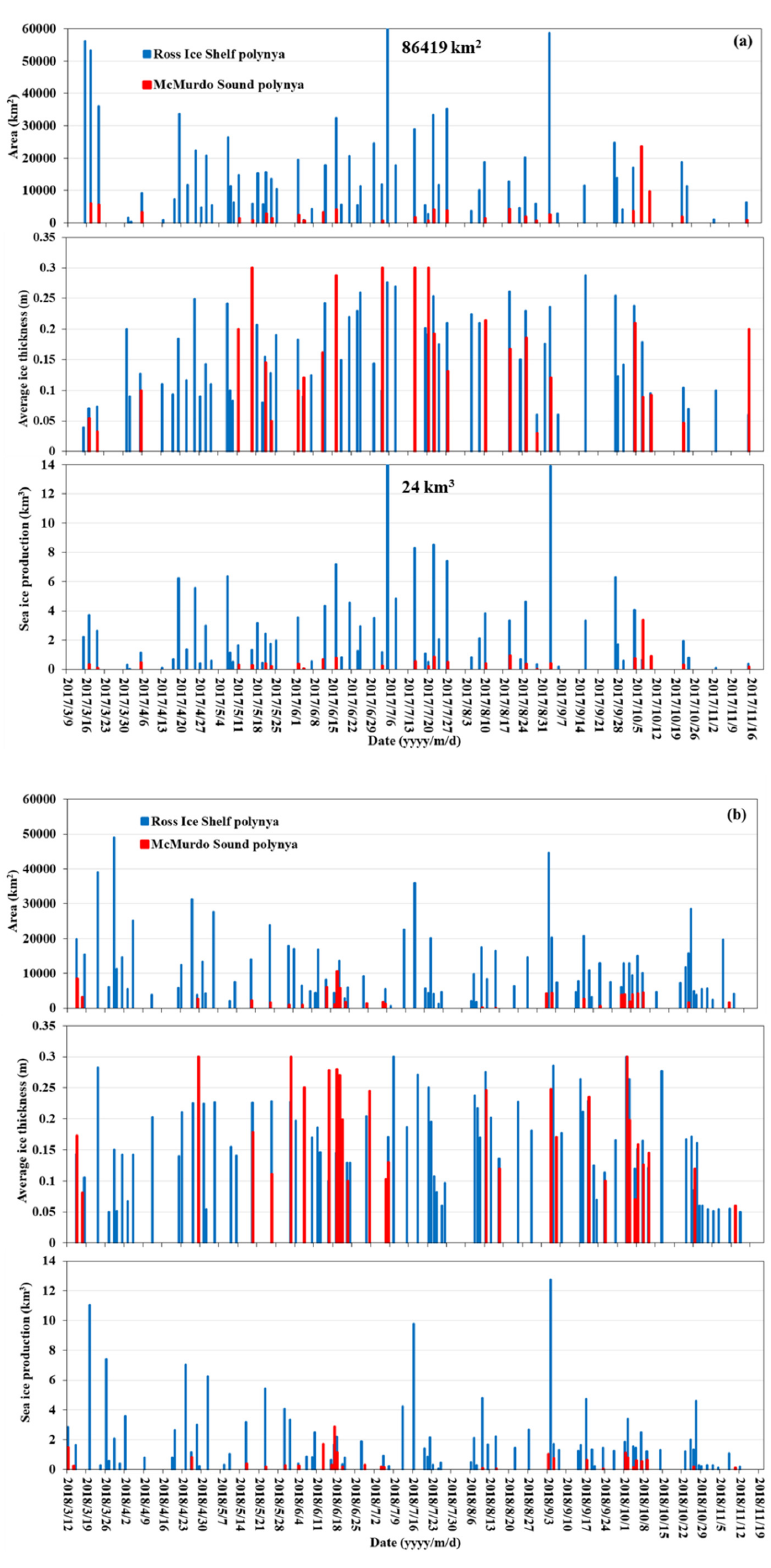
Figure 6. Wind-driven ice production areas, average thickness, and volumes for every event at the McMurdo Sound and Ross Ice Shelf polynyas (RISP) in 2017 ( a ) and 2018 ( b ). (The polynya area and polynya ice production of RISP on 5 July 2017, exceed the top scale. They are 86,419 km 2 , and 24 km 3 ,